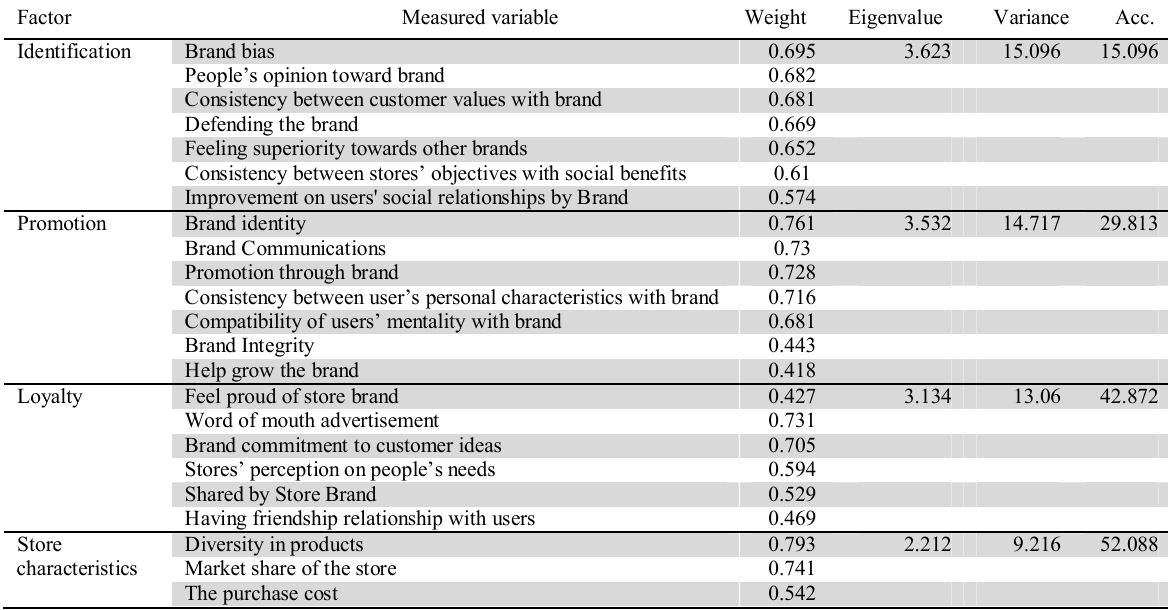
The summary of factor